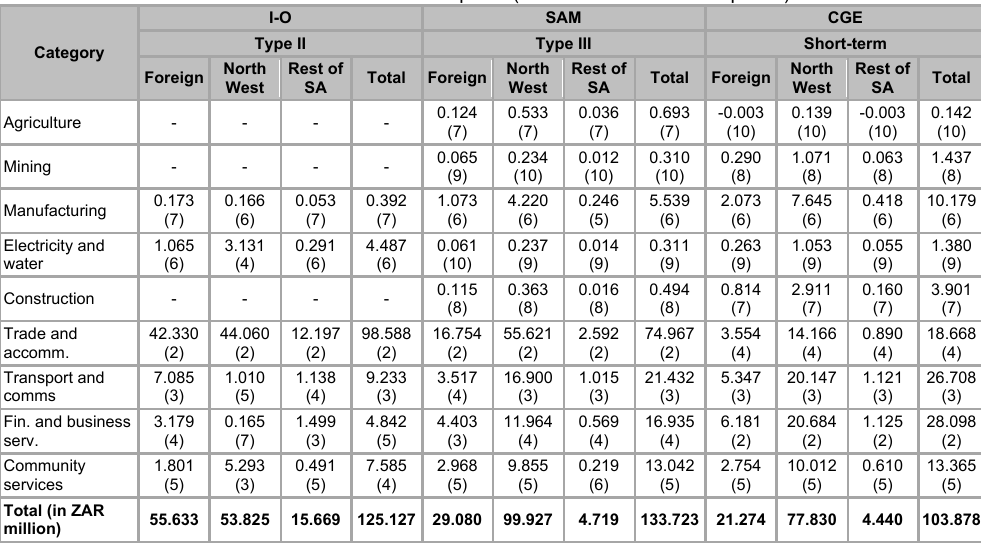
Table 6 Distribution of value-added impacts (in ZAR millions at 2006